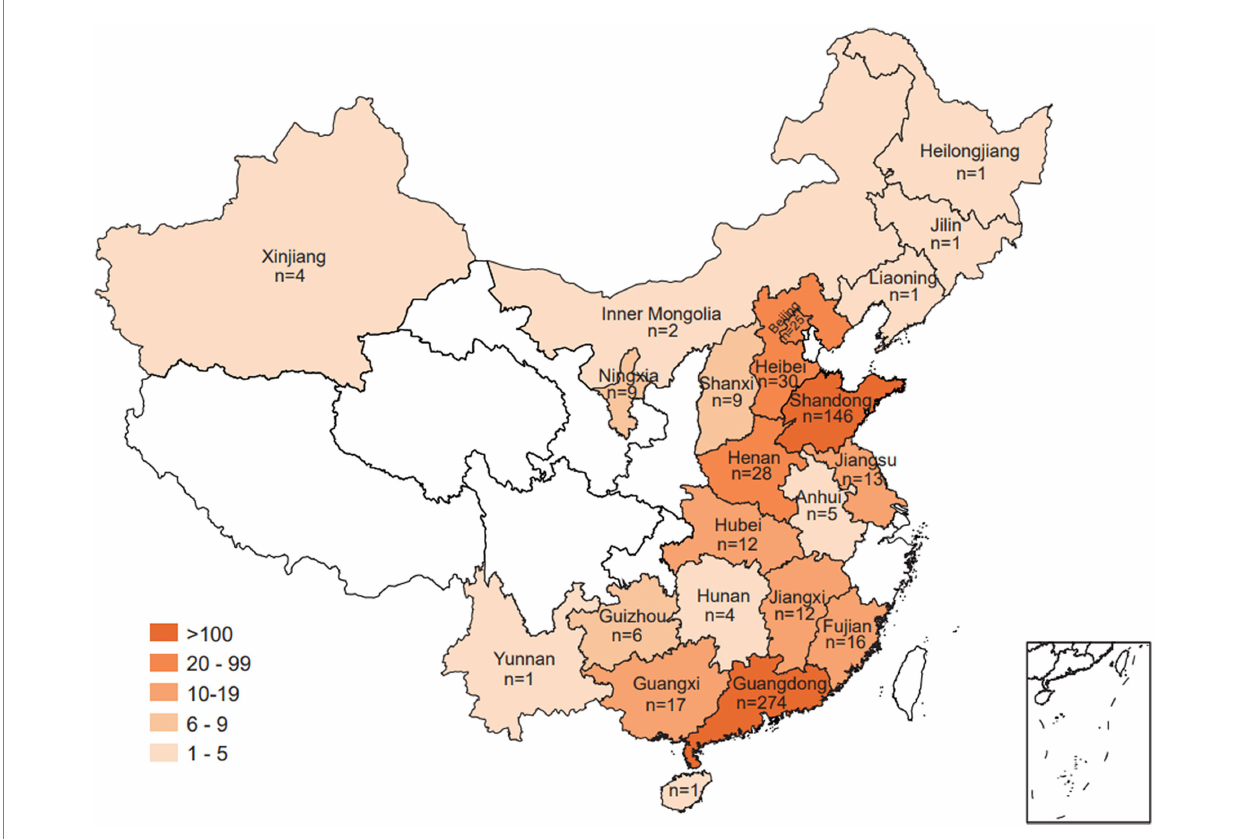
FIGURE 1 Geographic presentation of Salmonella isolates collected from food animals across different provinces of